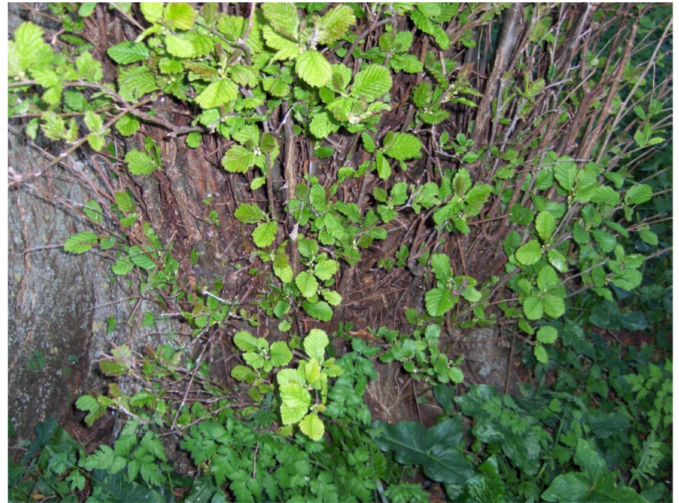
Figure 3. Pronounced shoot proliferation at the base of trunk of a several-year-old alder ( Alnus glutinosa ) tree affected by alder yellows